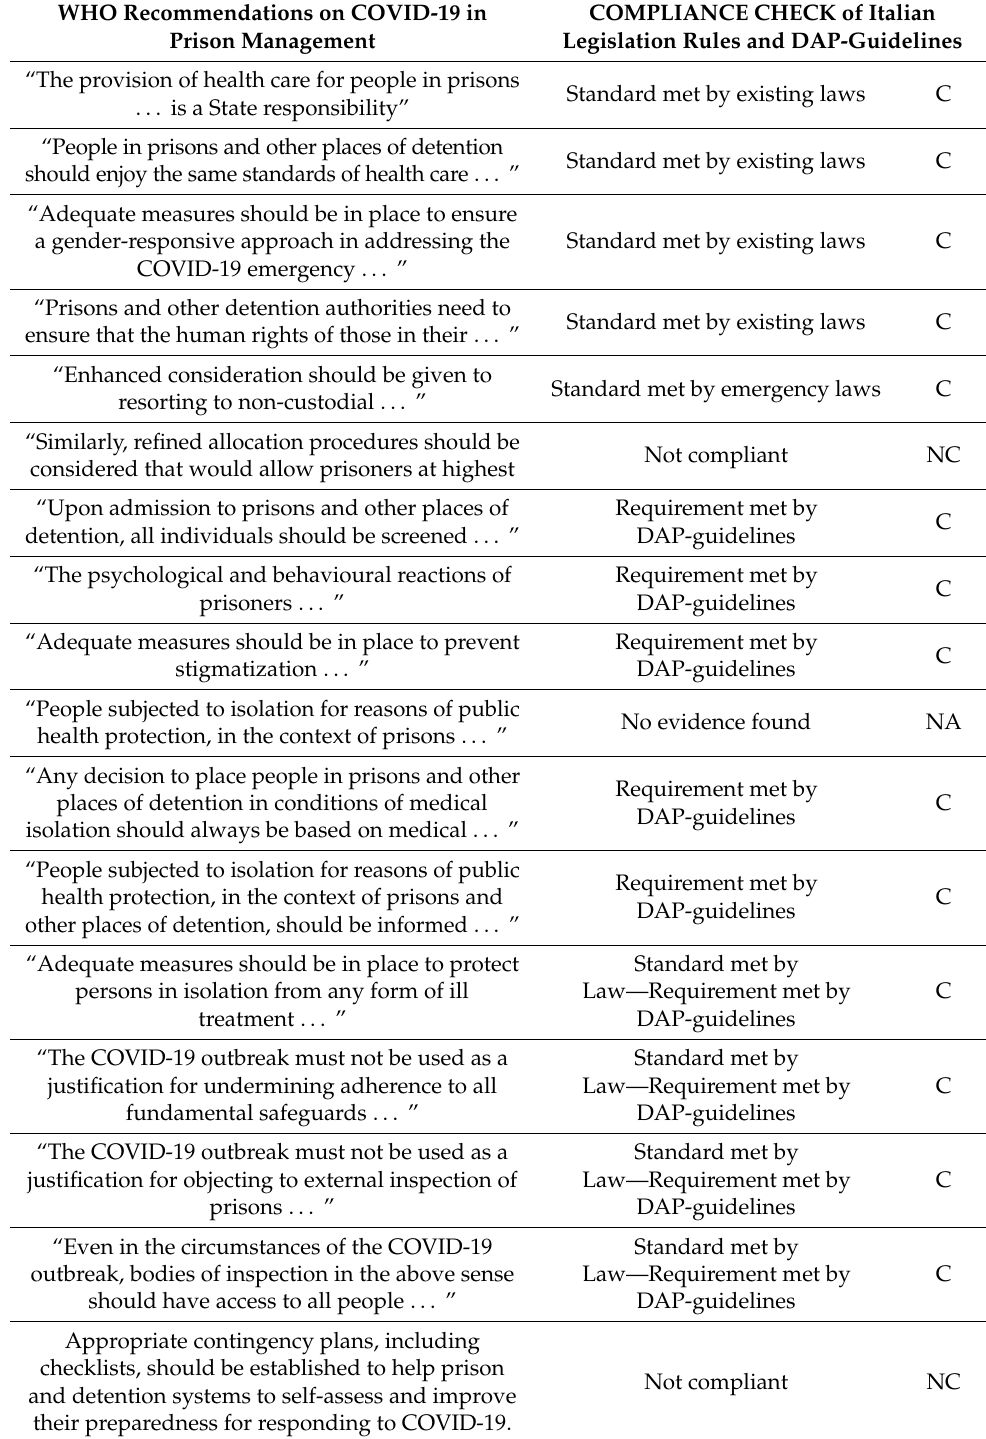
Table 2. Comparison between expected/observed interventions (Compliant—C; Non-Compliant— NC; Data not